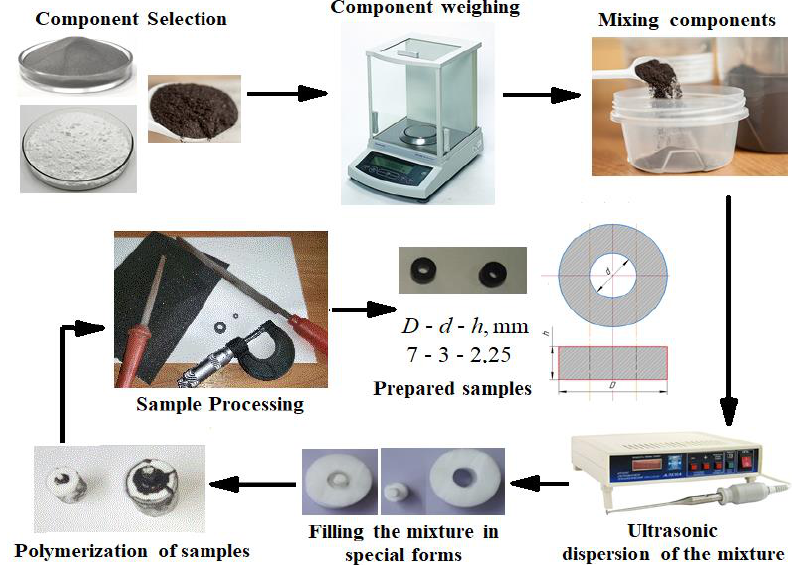
Fig. 1. Scheme of manufacturing samples of composite